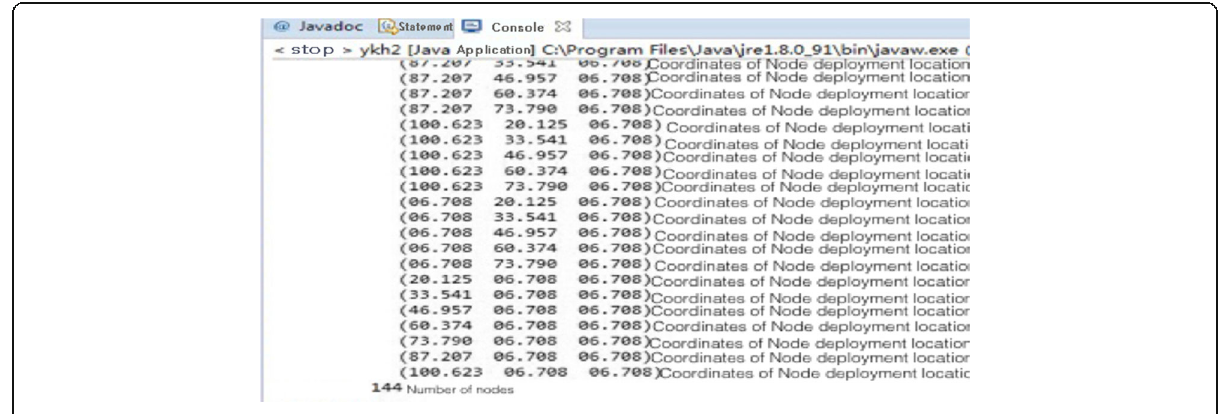
Fig. 5 Wireless sensor node coordinates